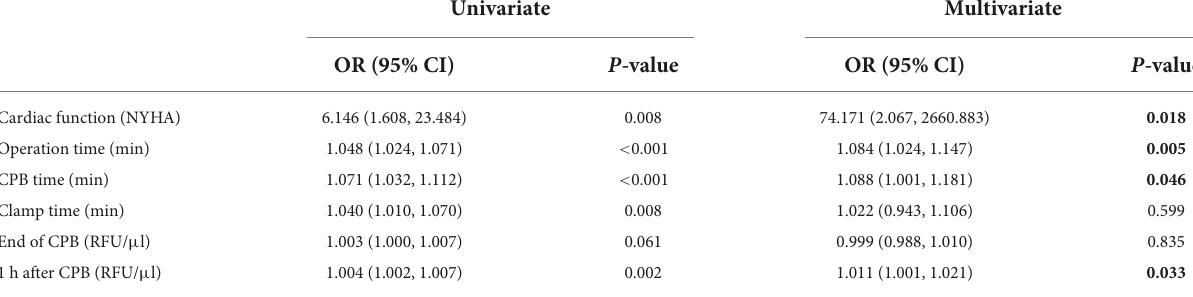
TABLE 3 Univariate and multivariate analysis of serum level of calpains after cardiopulmonary bypass (CPB) for prediction of acute lung injury (ALI). Univariate